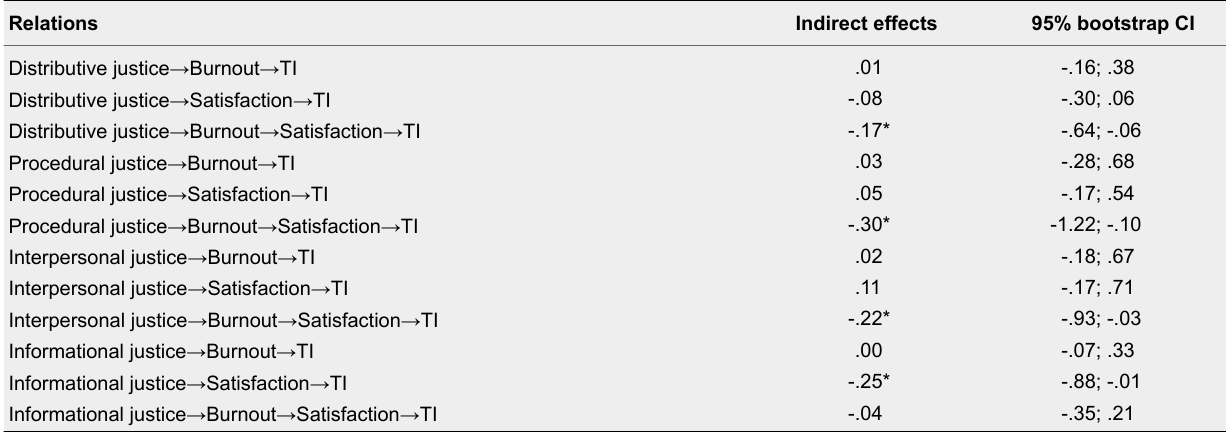
Indirect Effects of Organizational Justice on